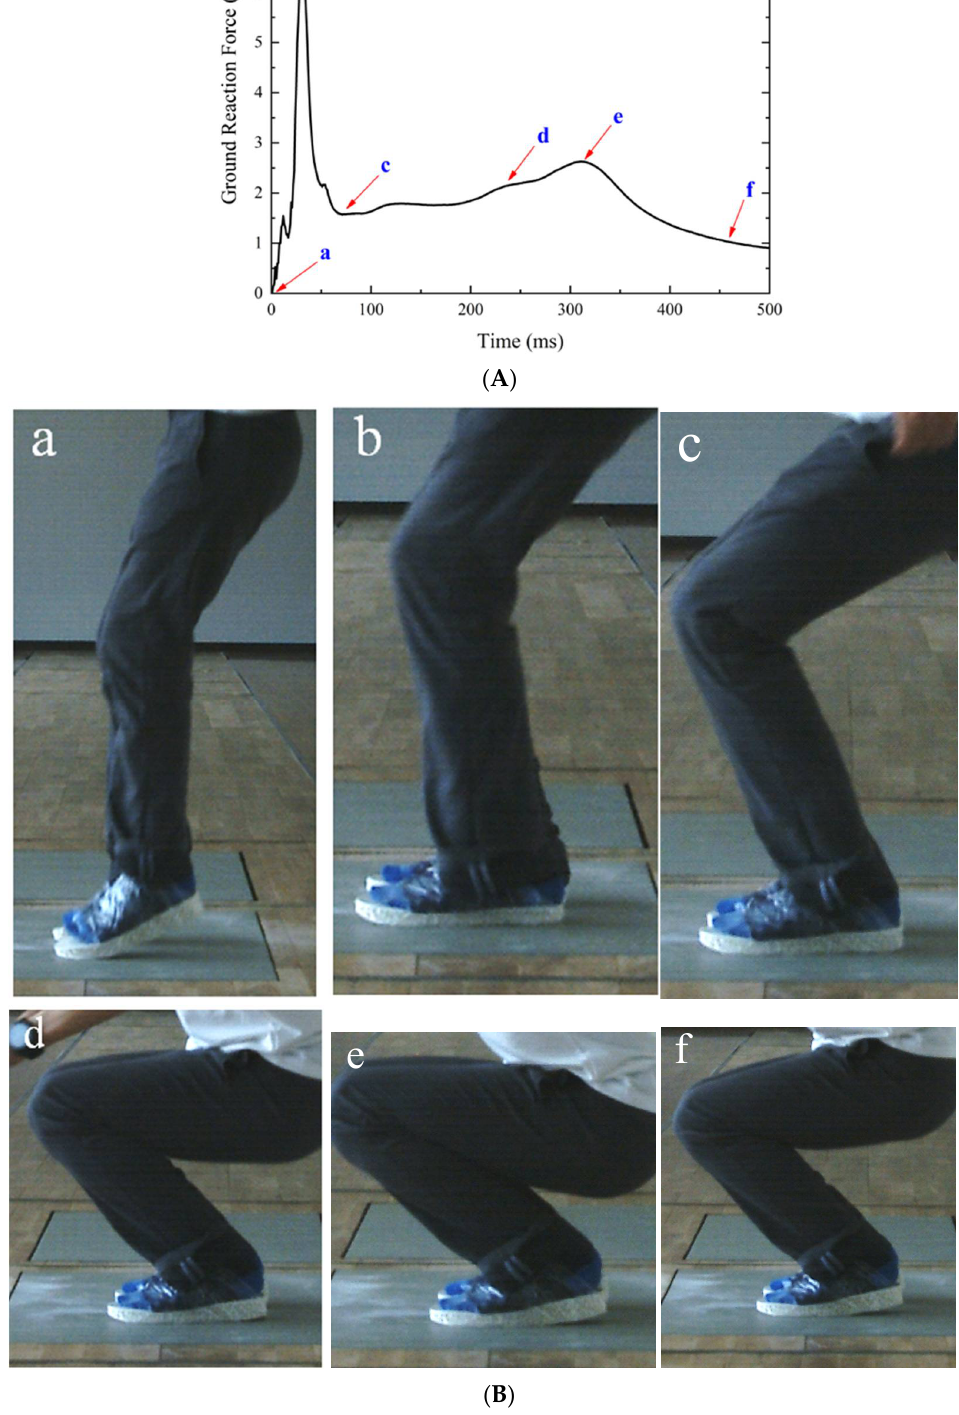
Figure 11. Results of drop landing tests: ( A ) representative GRF curve; ( B ) motion of lower extremities during landing.